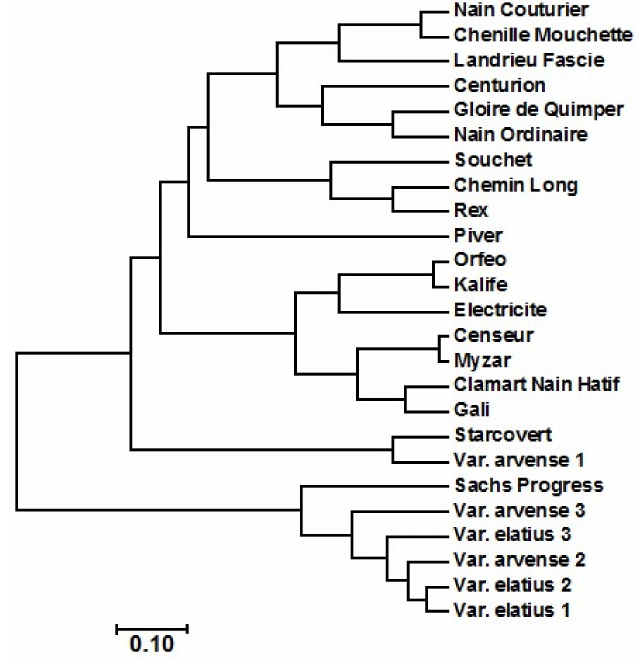
Figure 2. Cluster analysis of the 25 accessions of Pisum sativum L. using fatty acids data and crude oil